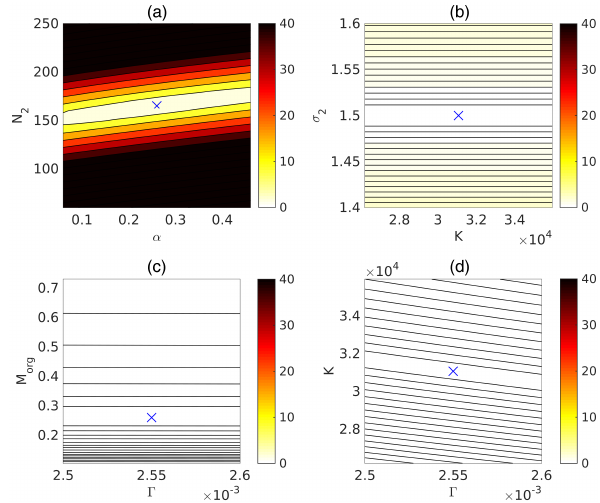
Figure 9. Response surfaces for a np w σ nf in the marine average en- vironment. Blue crosses indicate the true parameter values θ true used to calculate the calibration data. The colour scale represents the value of the OF calculated for the modelled spectra against the calibration data for parameter values across the uncertainty ranges (Table 2).